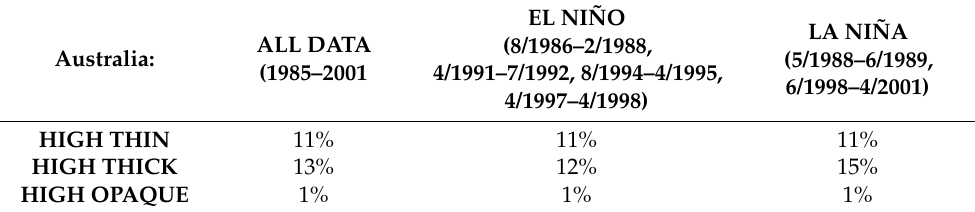
279 280 281 282 283